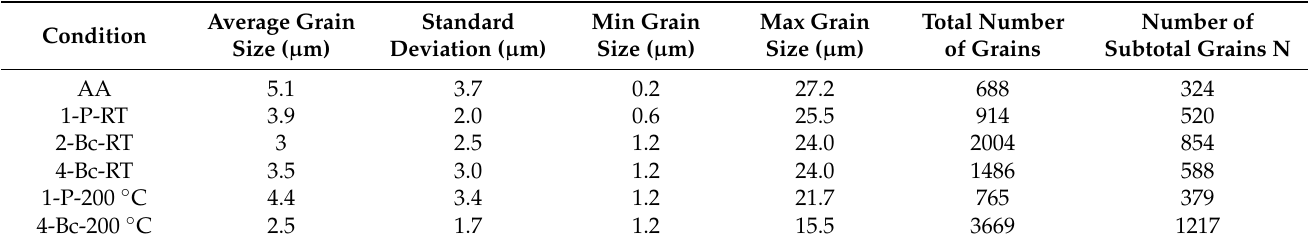
Table 1. The average grain size of the commercial purity Cu processed through ECAP up to 4-Bc.